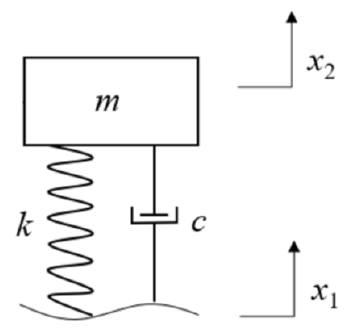
Figure 20. The one-way vibration model.